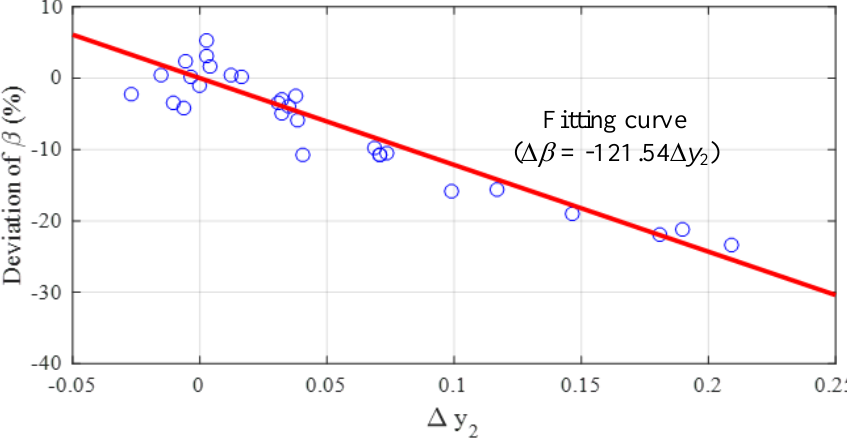
Figure 8. Deviation of β versus the undershoot factor ( Δ y 2 ).